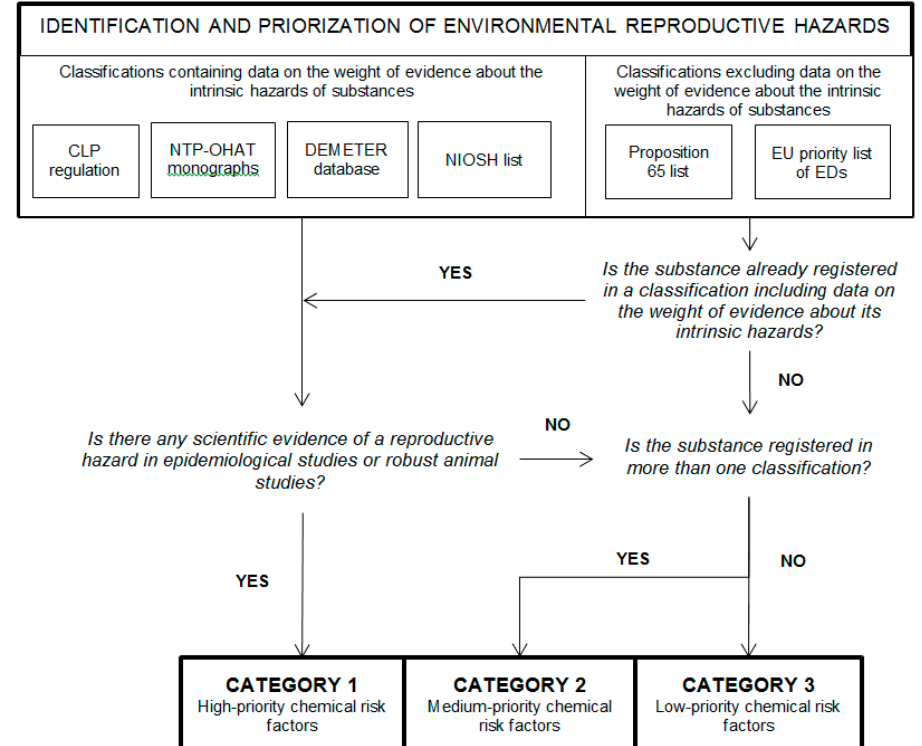
Figure 1. Method for identifying and prioritizing risk factors. CLP: the European regulation on the classification, labeling, and packaging of substances and mixtures; NTP-OHAT: National Toxicology Program Office of Health Assessment and Translation; DEMETER: Documents pour l ʹ Évaluation Médicale des produits Toxiques vis ‐ à ‐ vis de la Reproduction; NIOSH: National Institute for Occupational Safety and Health; and ED: Endocrine Disrupters.